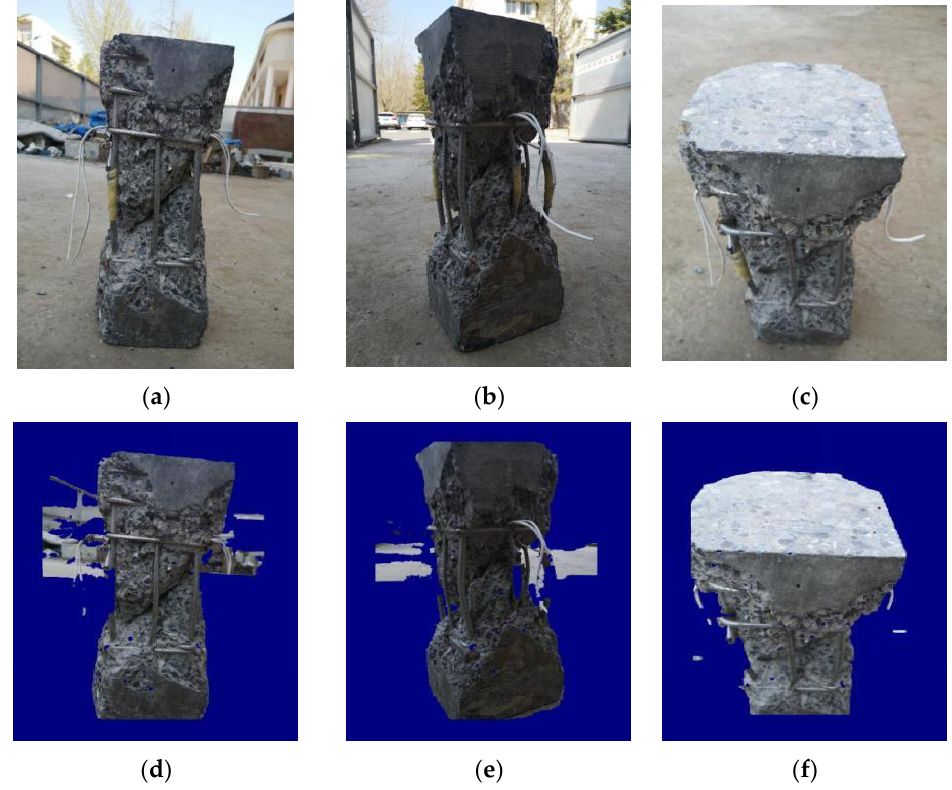
Figure 4. Comparison of the original images and the images after interactive segmentation. ( a – c ) original images, ( d – f ) the images after interactive segmentation.